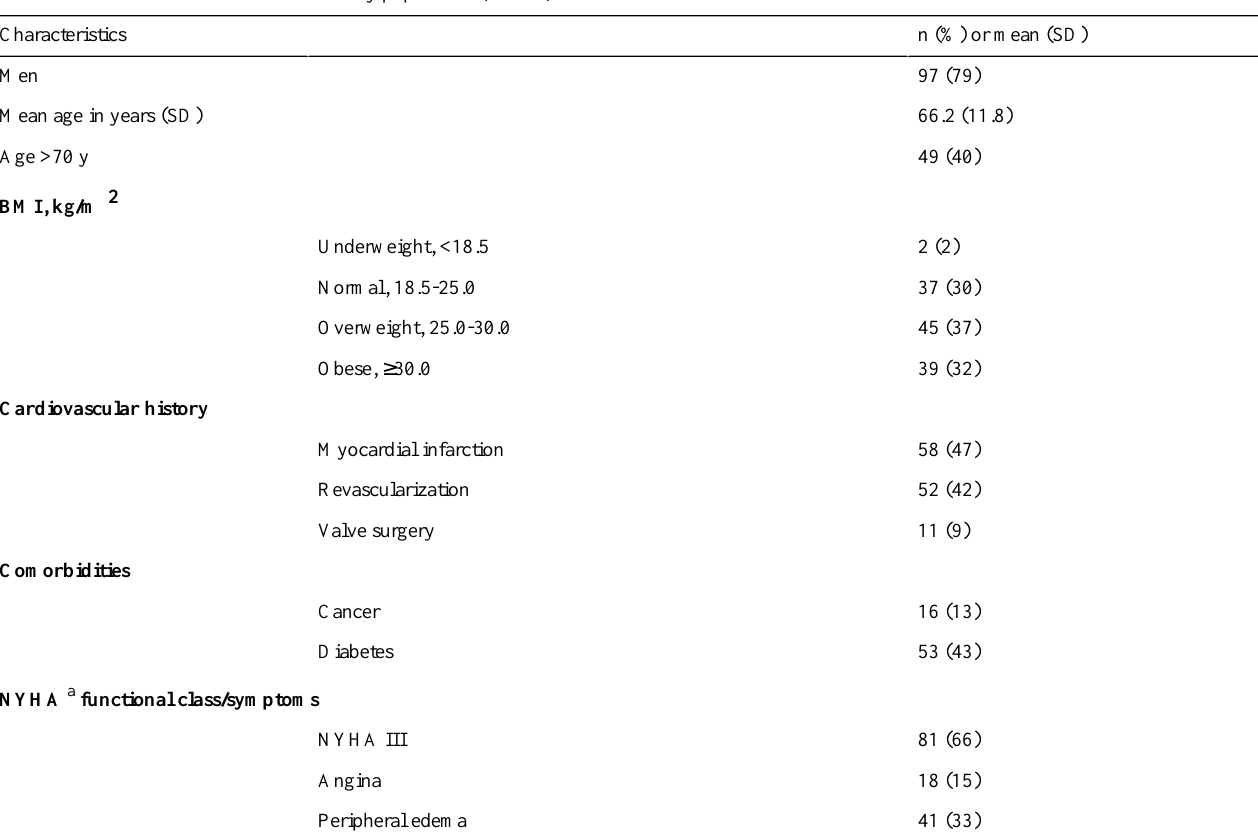
Table 1. Baseline characteristics of the study population